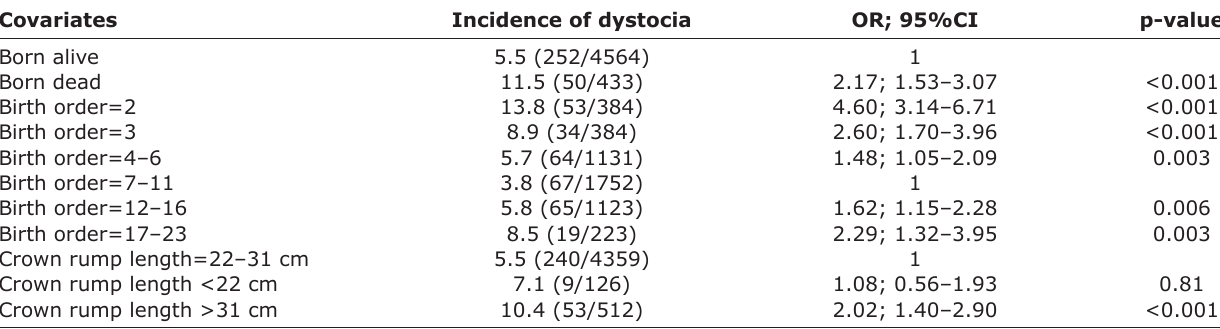
Table-1: Multivariate generalized linear mixed models for the association between potential risk factors and dystocia in 4997 piglets born from 387 sows in six herds in the North of Vietnam.